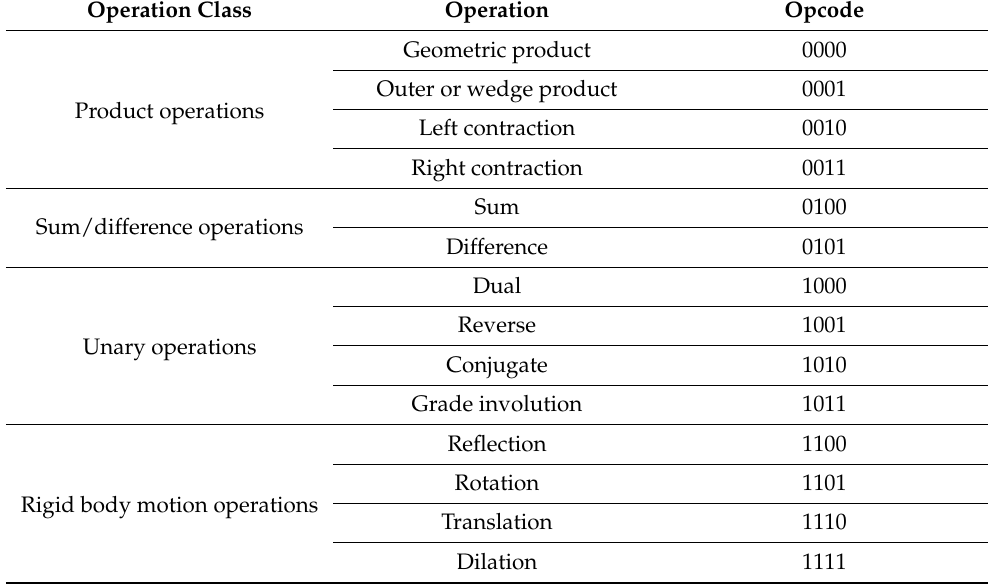
Table 1. Supported operations and related